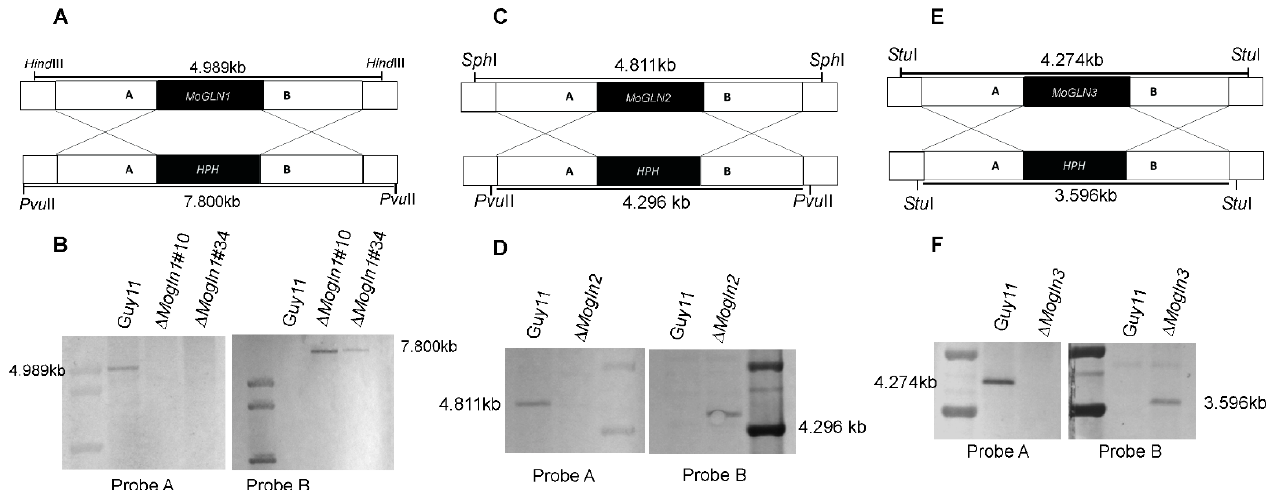
Figure 3. Southern blot analysis to confirm MoGLN deletion mutants. ( A , B ) Sketch representation of deletion of MoGLN1 in the M. oryzae genome and southern blot analysis of the gene knockout mutants and WT Guy11 via MoGLN1 ORF probe A and hygromycin phosphotransferase ( HPH ) probe B. ( C , D ) Sketch representation of deletion of MoGLN2 in M. oryzae genome and southern blot analysis of the gene knockout mutant and WT Guy11 via MoGLN2 ORF probe A and hygromycin phosphotransferase ( HPH ) probe B. ( E , F ) Sketch representation of deletion of MoGLN3 in the M. oryzae genome and southern blot analysis of the gene knockout mutant and the WT Guy11 using MoGLN3 ORF probe A and hygromycin phosphotransferase ( HPH ) probe